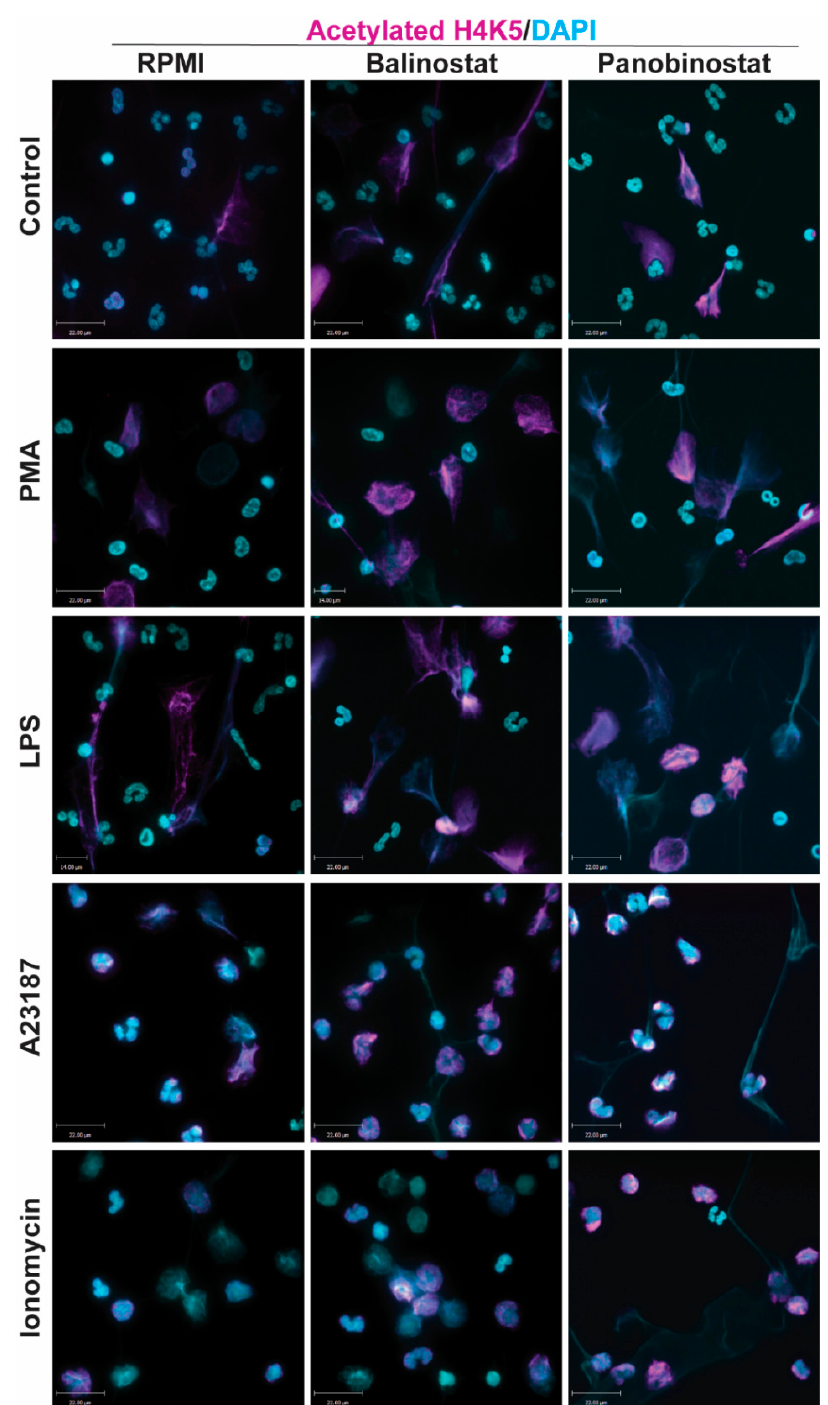
Figure 1. Confocal microscopy images showing histone deacetylase inhibitors (HDACi) promote histone acetylation. Neutrophils were treated with negative control (RPMI media), or NETotic agonists (25 nM PMA; 4 μ M A23187; 5 μ g/mL lipopolysaccharides (LPS) from E. coli 0128; 5 μ M Ionomycin) for 120 min. Cells were then fixed, immunostained, and imaged for histone acetylation (H4K5ac) and DNA (DAPI). Cells treated with RPMI show typical polymorphonuclear morphology of neutrophils. When treated with HDACis, belinostat and panobinostat, neutrophils show a further increase in histone acetylation. Blue, DAPI staining for DNA; Magenta, H4K5ac. Scale bar, 14 μ m. n = 2–3. See Supplementary Figures S1–S3 for single channel confocal images.